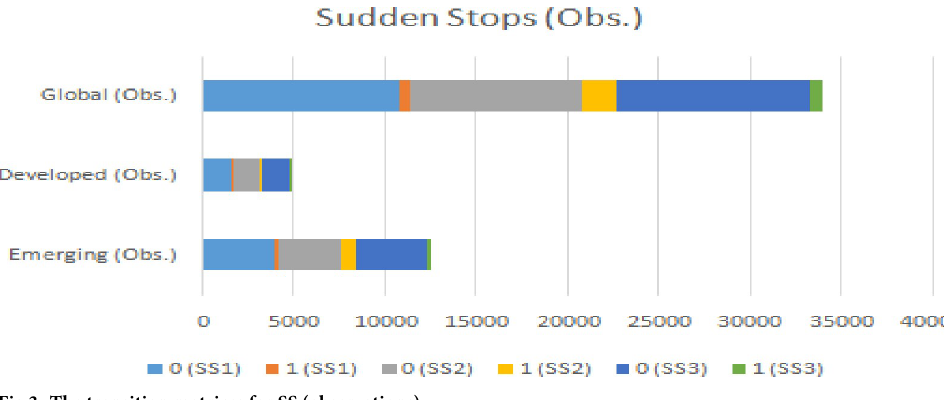
Fig 3. The transition matrices for SS